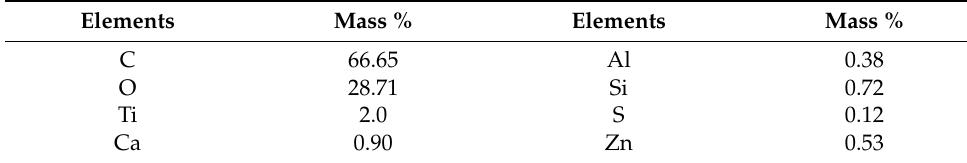
Figure 2. SEM micrographs of ( a ) AC and ( b ) TiO 2 /AC. Table 2. Elemental composition of TiO 2 /AC.